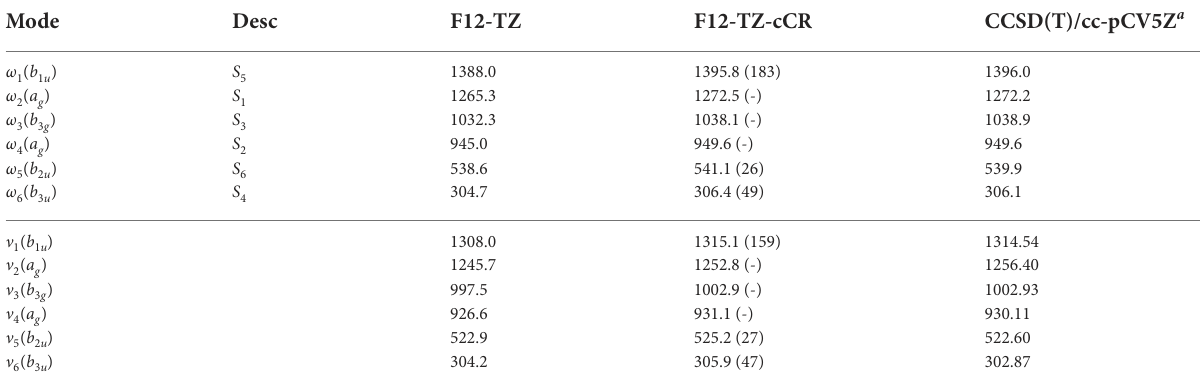
TABLE 1 Harmonic ( ω ) andFundamental ( ν ) VibrationalFrequencies(incm −1 )withIntensities(inkm mol −1 ,inParentheses)for r -C 4 .Modedescriptions (Desc.)refertotheSICsinEqns.1-24. Mode